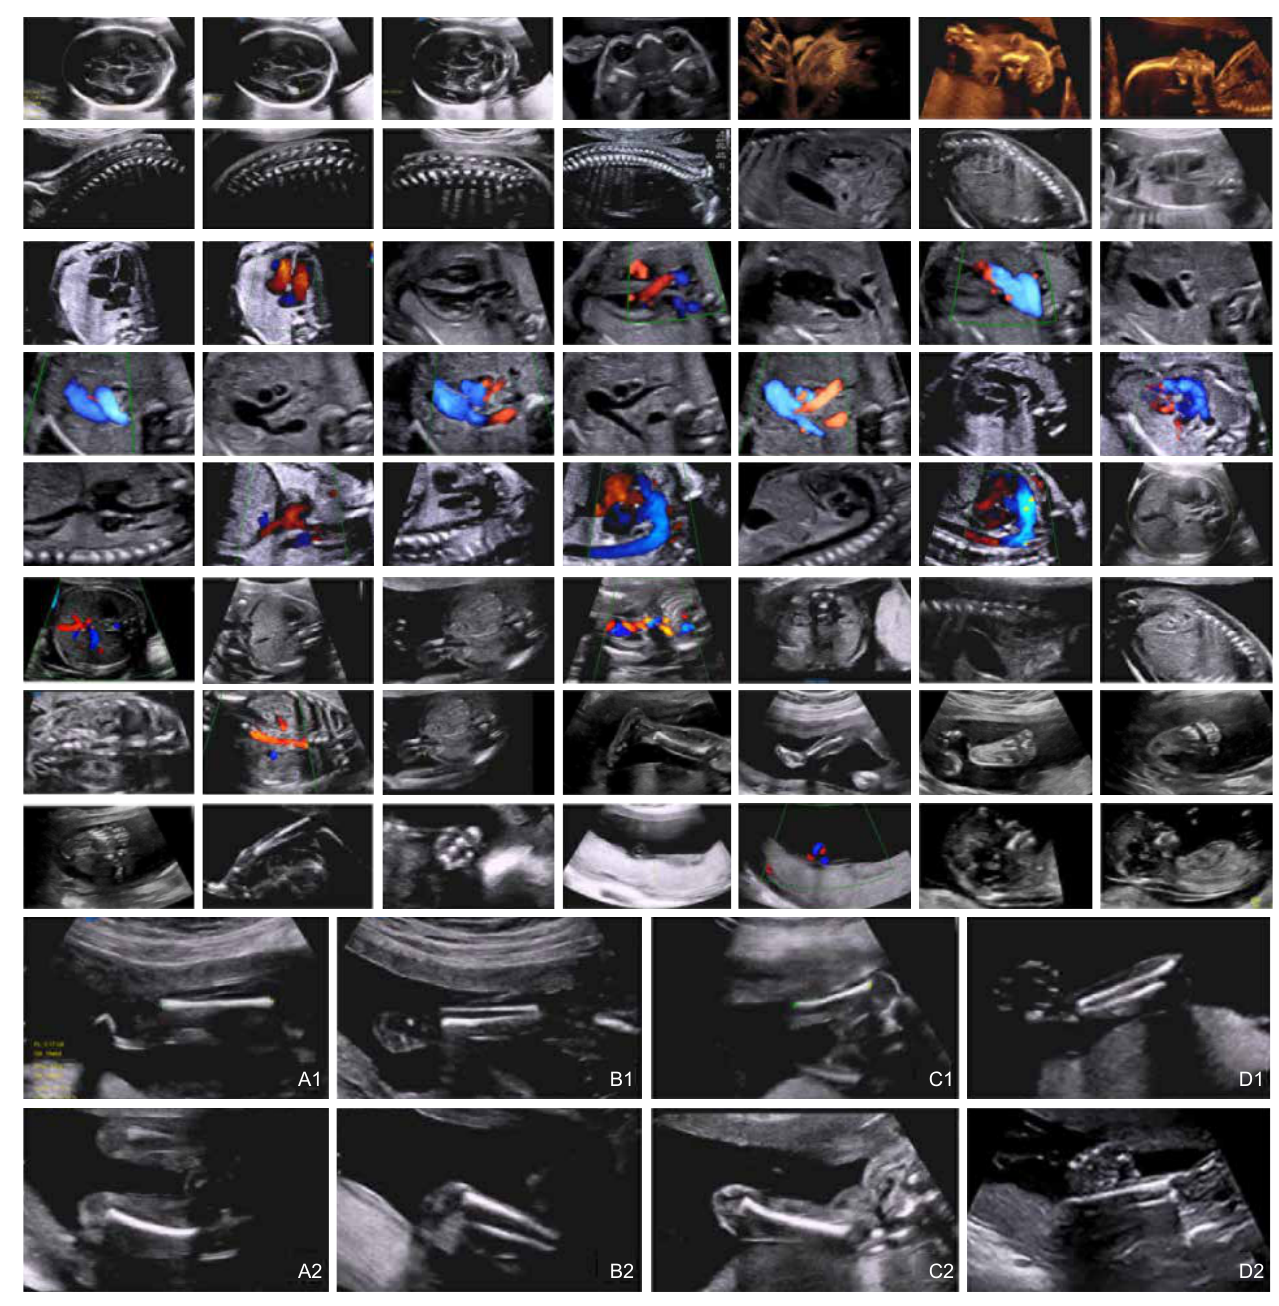
Figure 2 64 prenatal ultrasound sections automatically acquired by Lanwon ultrasound PACS. (A1-A2) Bilateral femurs; (B1-B2) Bilateral tibial fibula; (C1-C2) Bilateral humerus; (D1-D2) Bilateral ulnar